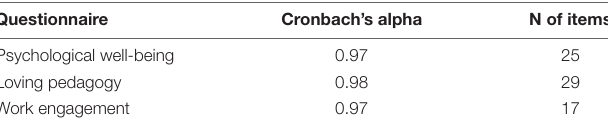
TABLE 1 | Reliability of the questionnaires.